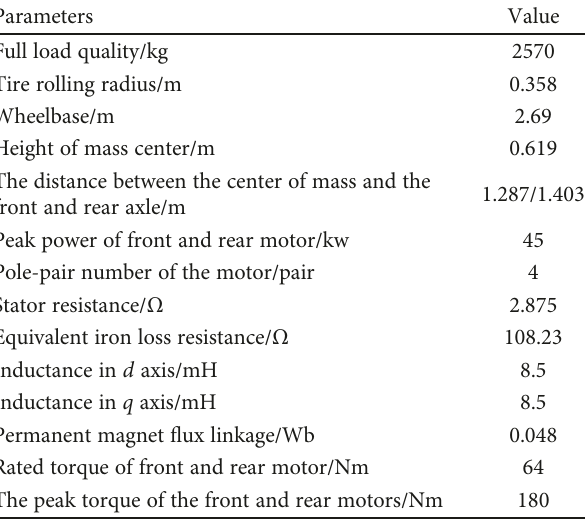
Table 1: Example vehicle model